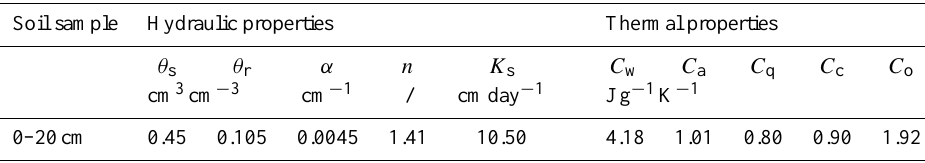
Table 2. Soil hydraulic (Van Genuchten, 1980) and thermal (De Vries, 1963) properties including saturated ( θ s ) and residual ( θ r ) water content; curve-fitting parameters ( α and n) ; saturated hydraulic conductivity ( K s ) ; specific heat capacities of the water ( C w ) , air ( C a ) , quartz ( C q ) , clay ( C c ) , and organic matter ( C o )